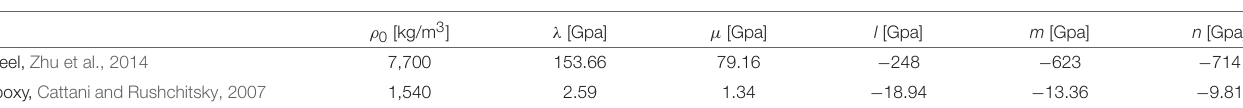
TABLE 1 | Material constants for the steel and the epoxy.